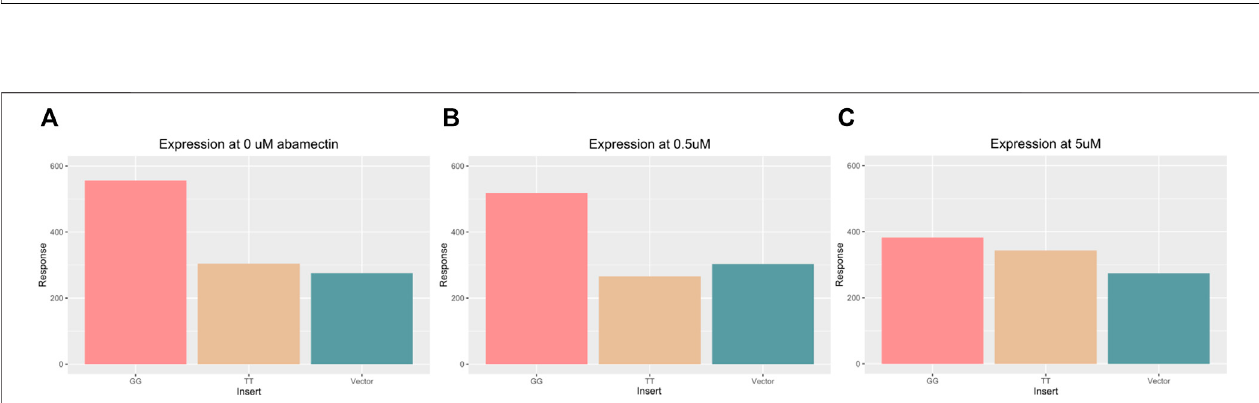
FIGURE 5 | EMSA showing a competition assay done with varying concentrations of untagged GG and TT oligos. The fi rst lane has no competitors in it and demonstrates the shift that happens when the tagged GG oligo and the protein lysate are added to the well. The band is highlighted by a red arrow. An example of the difference in bands when the GG or TT competitors are added is highlighted with a red box. The GG competitor produces a much lighter band, indicating that the GG sequence has more af fi nity for the protein that is being bound than the TT sequence.